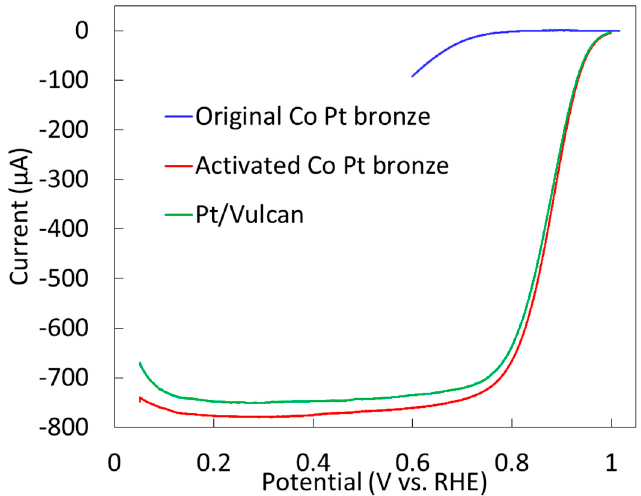
Figure 11. ORR activity measurement voltammogram of activated Co-Pt bronze compared with original Co-Pt bronze and Pt/Vulcan.